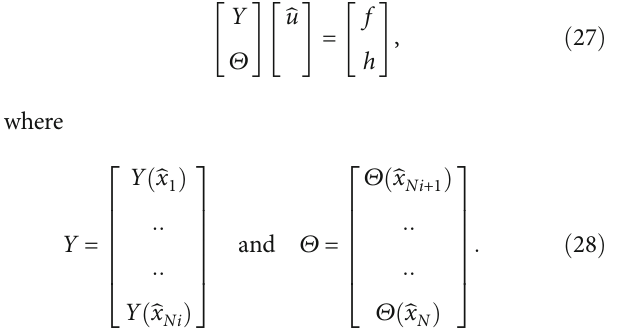
for 2D (left) and nine-node local domain for 3D s